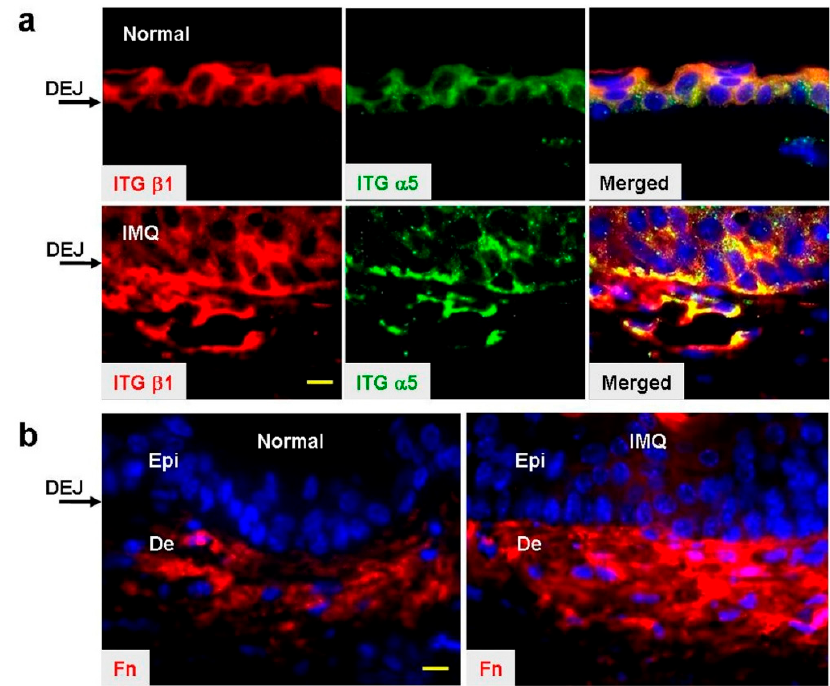
Figure 3. Immunofluorescence analysis of mouse dorsal skin six days after Imiquimod (IMQ) treatment. ( a ) Representative skin sections from mice treated with control cream (normal) or IMQ cream, and dual-immunofluorescence stained for integrin (ITG) α 5 and β 1. Nuclei were stained by Hoechst 33258 (blue). DEJ: Dermal–epidermal junction. ( b ) Representative images of fibronectin (Fn) staining of normal and IMQ-treated skins. Epi: Epidermis; De: Dermis. Scale bar: 10 µ m. Results were evaluated from six sections of a skin specimen, with three mice in each group.